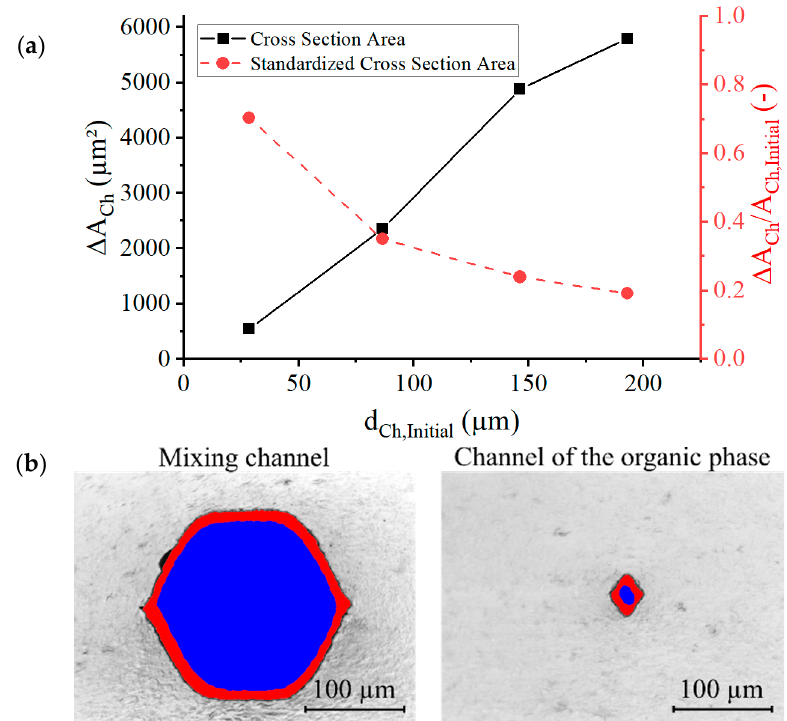
was more pronounced in narrower